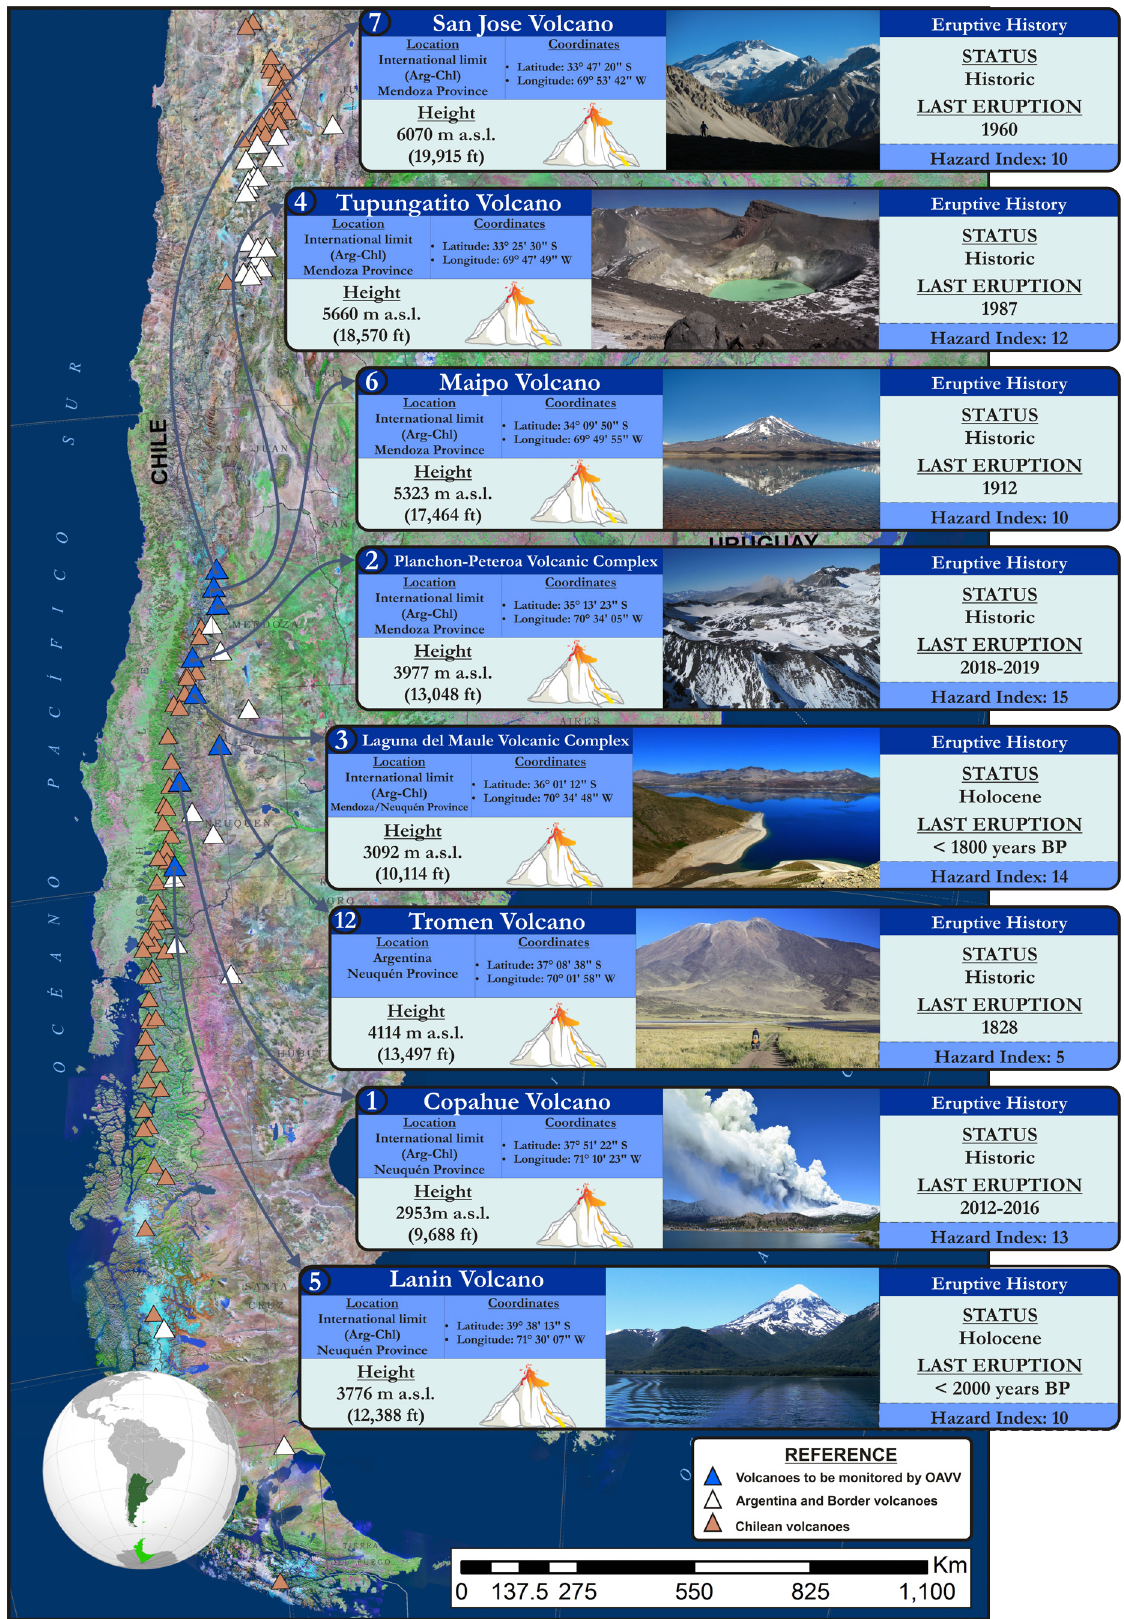
Figure 2: Regional location map of the volcanoes of the Andes; blue triangles indicate volcanoes that are moni- tored (or will be monitored in the future) [modified from García et al.